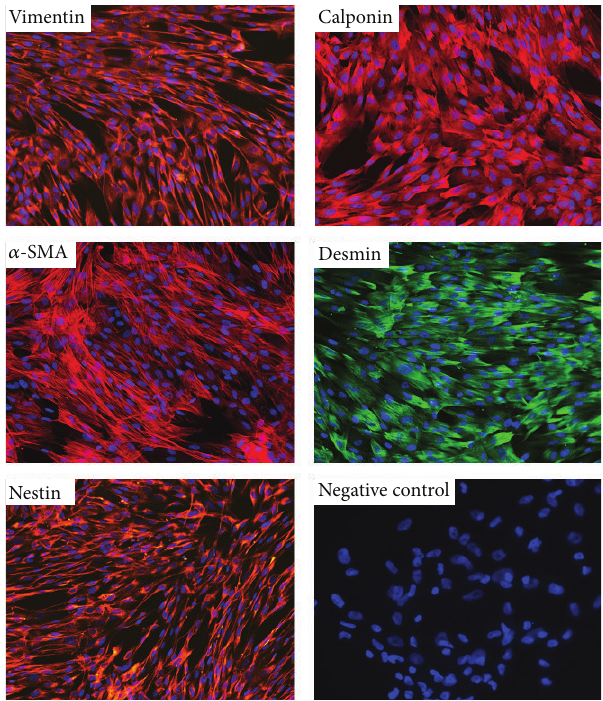
Figure 2: Expression of mesenchymal markers in FL-MSCs. Mes- enchymal markers (vimentin and nestin) and smooth muscle mark- ers (calponin, desmin, and 𝛼 -SMA) immunostaining was evaluated using validated corresponding primary antibodies and fluorescence microscopy. Images are representative of several fields examined from the four cell populations. Cell nuclei are stained using DAPI (blue). Negative control: secondary antibody alone. Magnification: